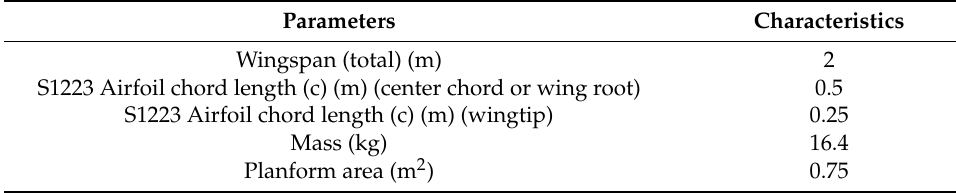
Table 2. Wing design